Question: Author a descriptive caption for the visualization shown.
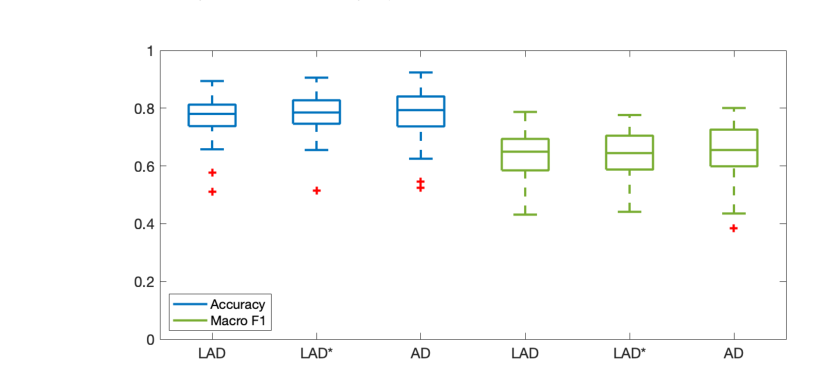
Answer: The box plot of 40-fold validation accuracies by dif- ferent methods. LAD stands for Landmark AD without class- balanced landmark set fusion 2 channels; LAD* stands for Land- mark AD with class-balanced landmark set fusion 2 channels AD stands for AD fusion 2 channels and O1A2, O2A1 stands for dif- fusion map on single channels.